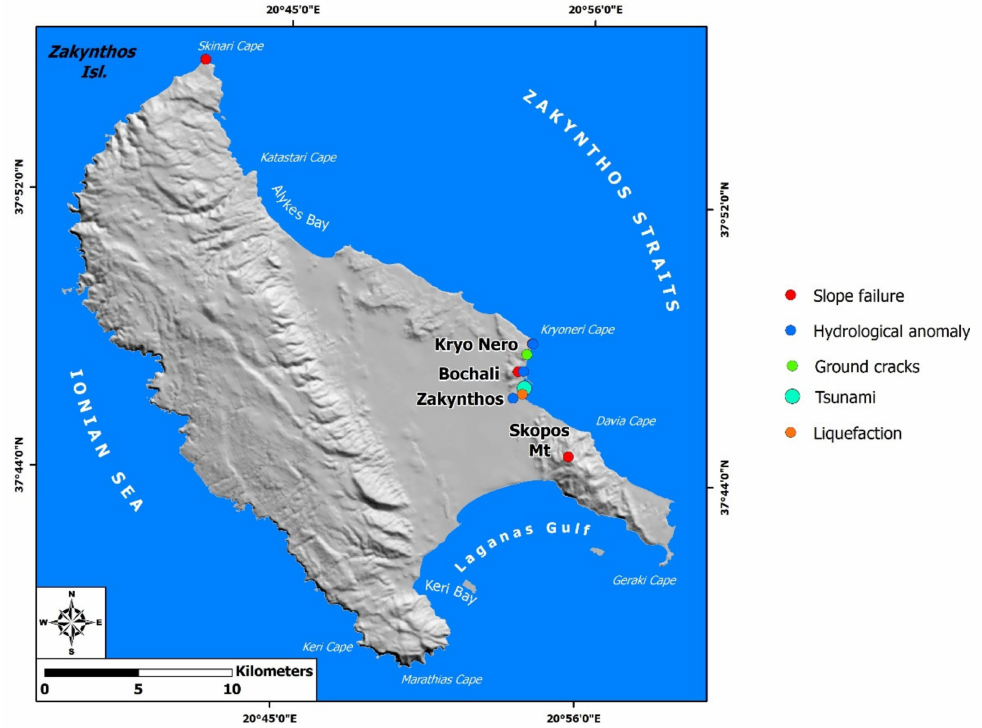
Figure 12. Secondary environmental effects induced by the 12 August 1953 Ionian Sea earthquake in Zakynthos